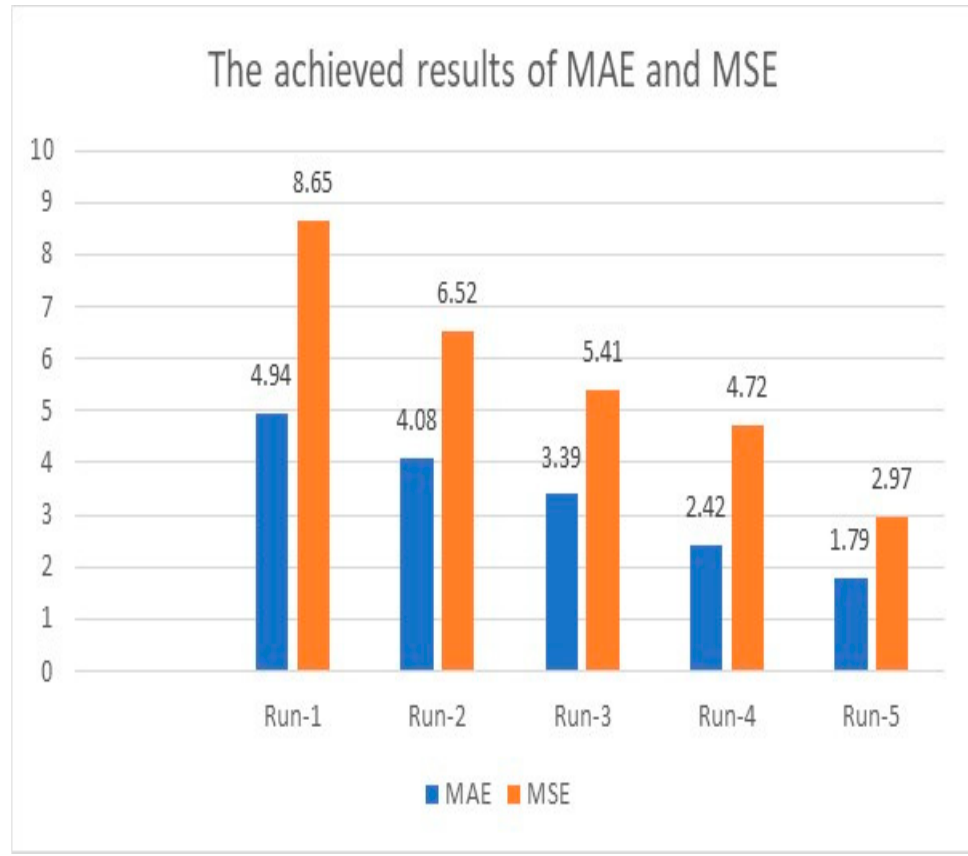
Figure 10. MAE and MSE analysis using the integrated deep learning approaches.